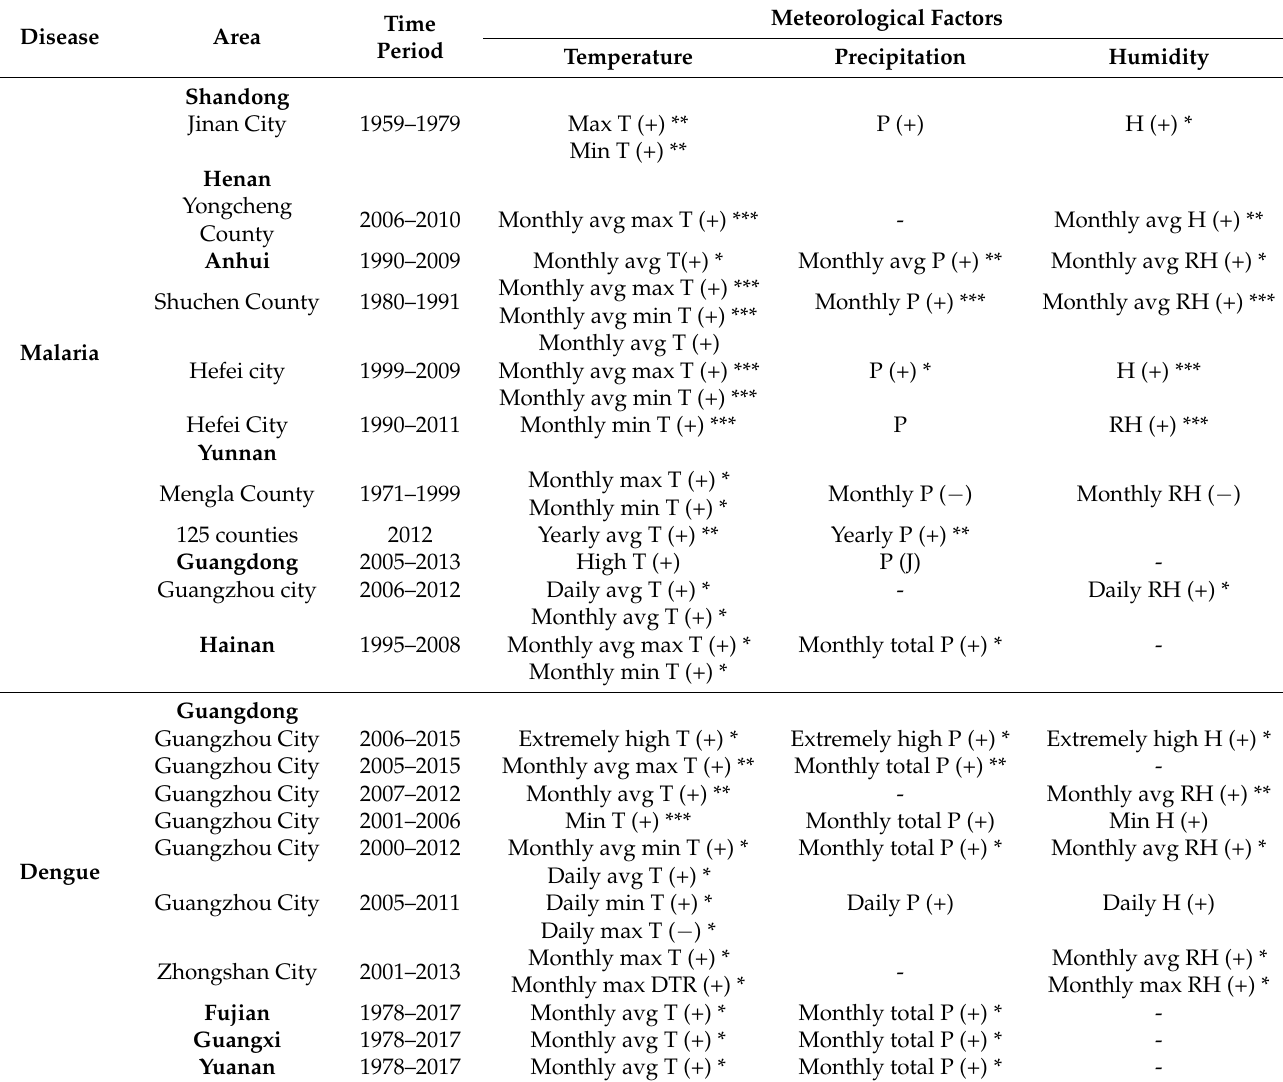
Table 2. The relationships between meteorological factors and vector-borne diseases according to the classification of different administrative regions in